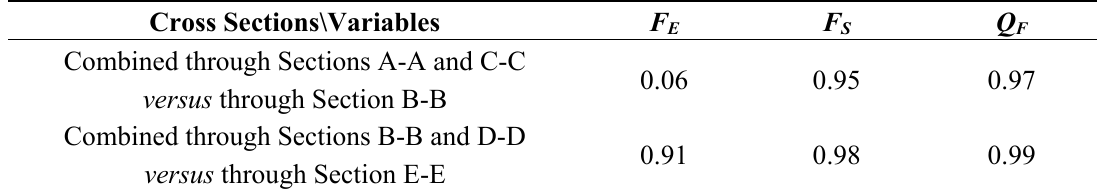
F Q E S F 0.06 0.95 0.97 0.91 0.98 0.99